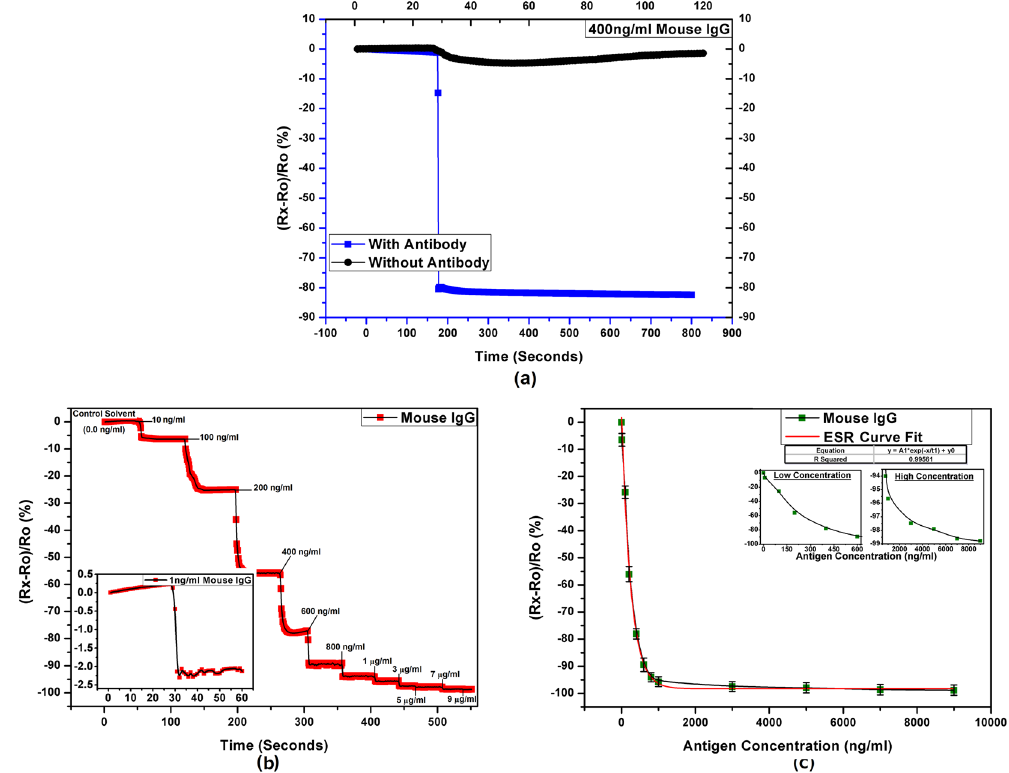
Figure 5. Electrical characteristics of the IgG immunosensor ( a ) response towards 400 ng/ml IgG with and without immobilized anti-IgG antibodies, ( b ) step response for increasing concentrations of IgG with inset showing LoD curve for 1 ng/ml IgG, and ( c ) response curve for the full tested range of IgG with insets showing the separated curves for low (0–800 ng/ml) and high (800–9000 ng/ml) concentration